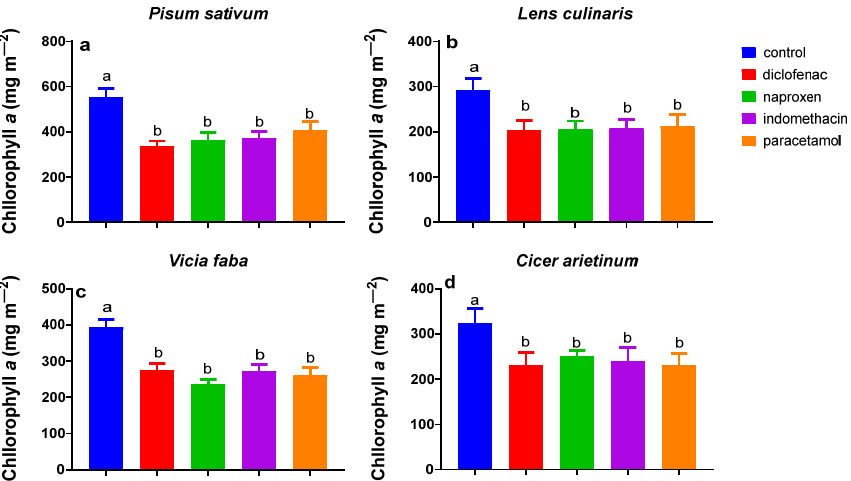
Figure 5. Chlorophyll a concentration from Pisum sativum ( a ), Lens culinaris ( b ), Vicia faba ( c ), and Cicer arietinum ( d ). Plants in 0.5 L pots filled with commercial garden soil were treated by watering 100 mL of 0.5 mg L − 1 NSAIDs every second day over a total of 20 days. The values are averages of four independent measurements. Data sharing different letters are significantly different ( p < 0.05), while data sharing the same letters are not significantly different ( p >